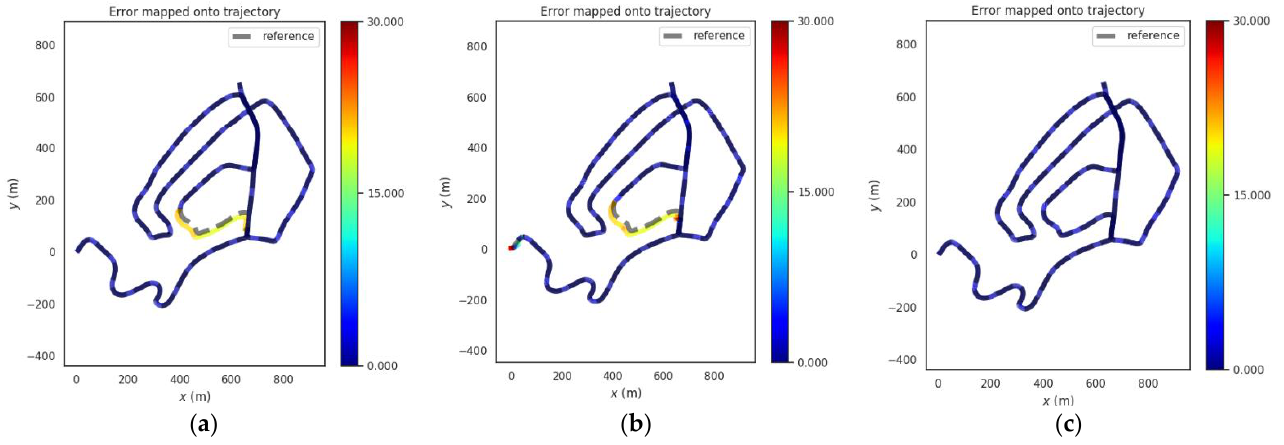
Figure 10. The absolute position error of the three methods in rural scene.